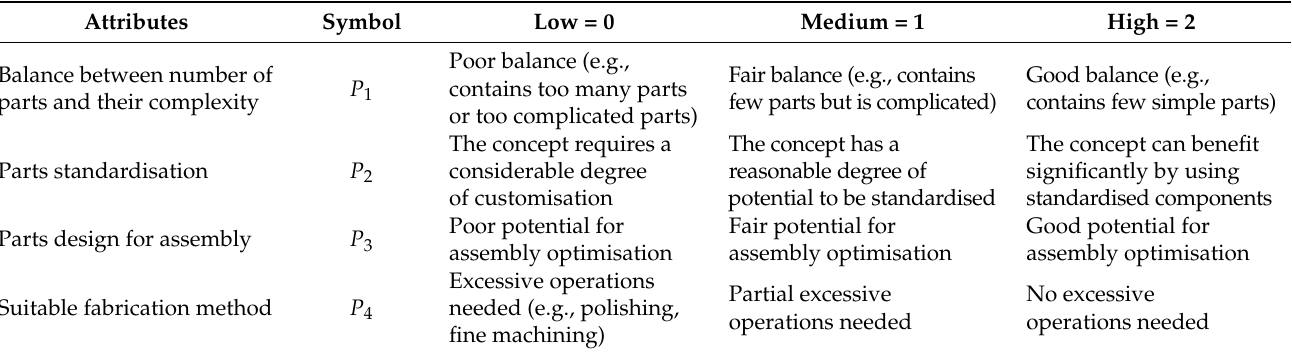
Table 4. Attributes for measuring concept production